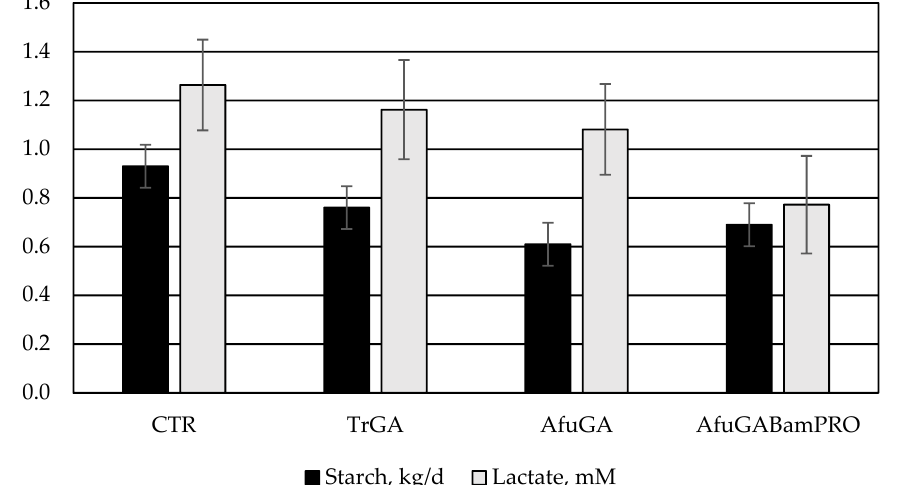
Figure 1. Daily fecal starch output (kg/d) and fecal D -lactate concentration (mM) in crossbred Angus bulls fed TMR supplemented with the different enzymes (TrGA = Trichoderma reesei glucoamylase; AfuGA = Aspergillus fumigatus glucoamylase; AfuGABamPro = Aspergillus fumigatus glucoamylase + Bacillus amyloliquefaciens neutral protease).